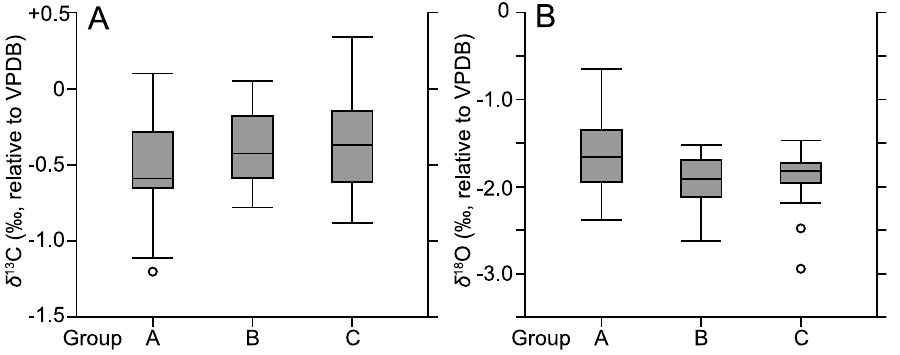
Fig 5. Box and whisker plots of δ 13 C and δ 18 O in three groups (A–C) of Globigerinoides ruber . Values for δ 13 C and δ 18 O are shown on the left (5A) and right (5B), respectively (i.e., n = 14 for group A, n = 20 for group B, and n = 15 for group C). Individual open circles correspond to outliers.